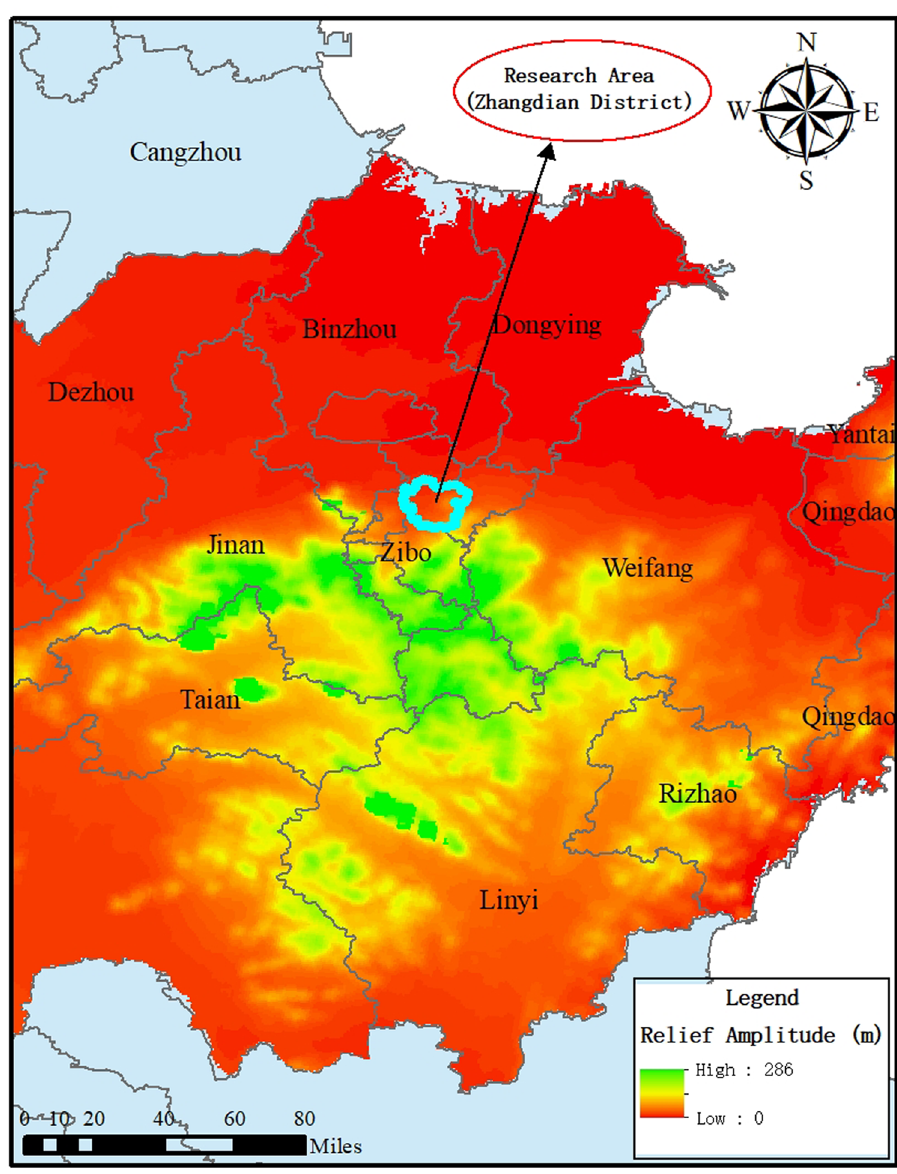
Figure 2. Relief amplitude of research area. The map was generated with ArcGIS10.2 (https:// www. esri. com/ en- us/ arcgis/ produ cts/ devel op- with- arcgis/ overv iew).